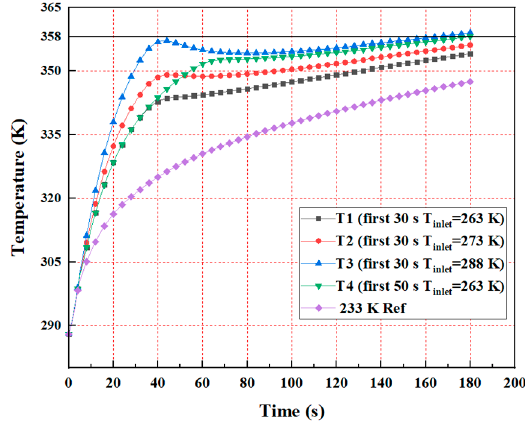
Figure 18. Four pre-cooling pa tt erns from the cylinders.